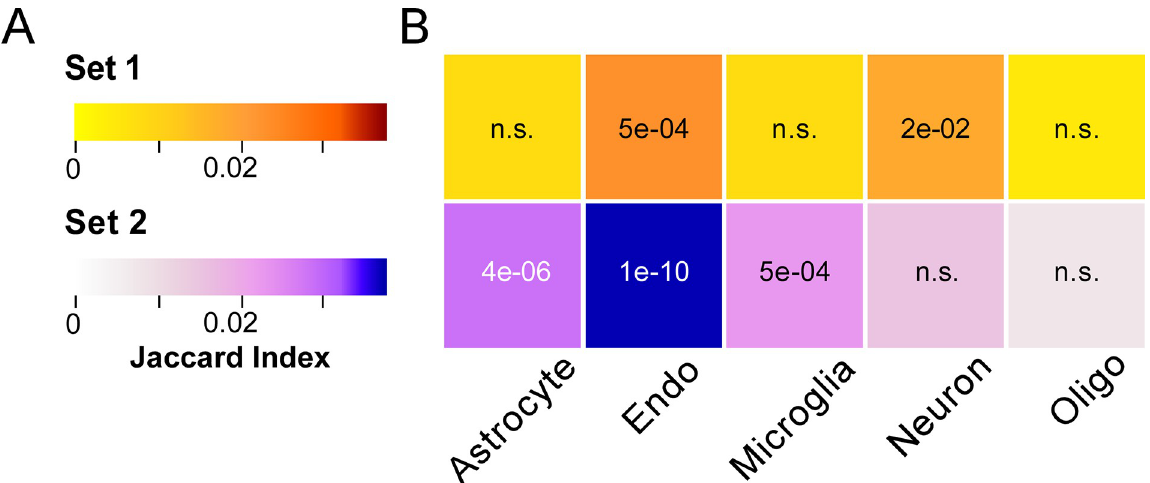
Fig 4. Enrichment analysis of Gene Sets 1 and 2. Overlap comparison of genes in Set 1 and 2 with previously reported cell-type specific markers from human brain [49] (Endo, endothelial cells; Oligo, oligodendrocytes), where color gradients indicate overlap by Jaccard index and numerals indicate Benjamini-Hochberg corrected p -values calculated by Fisher’s Exact Test. Both Sets 1 and 2 enriched for endothelial cell specific genes, while Set 1 enriched uniquely for neuron specific markers, and Set 2 uniquely for astrocyte and microglia specific markers.